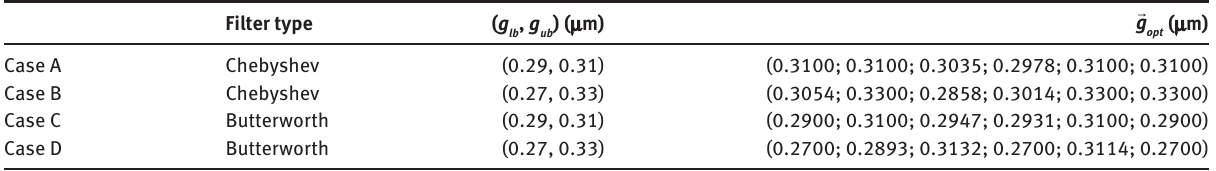
Table 1: Four simulated cases and the associated optimized gaps. Filter type